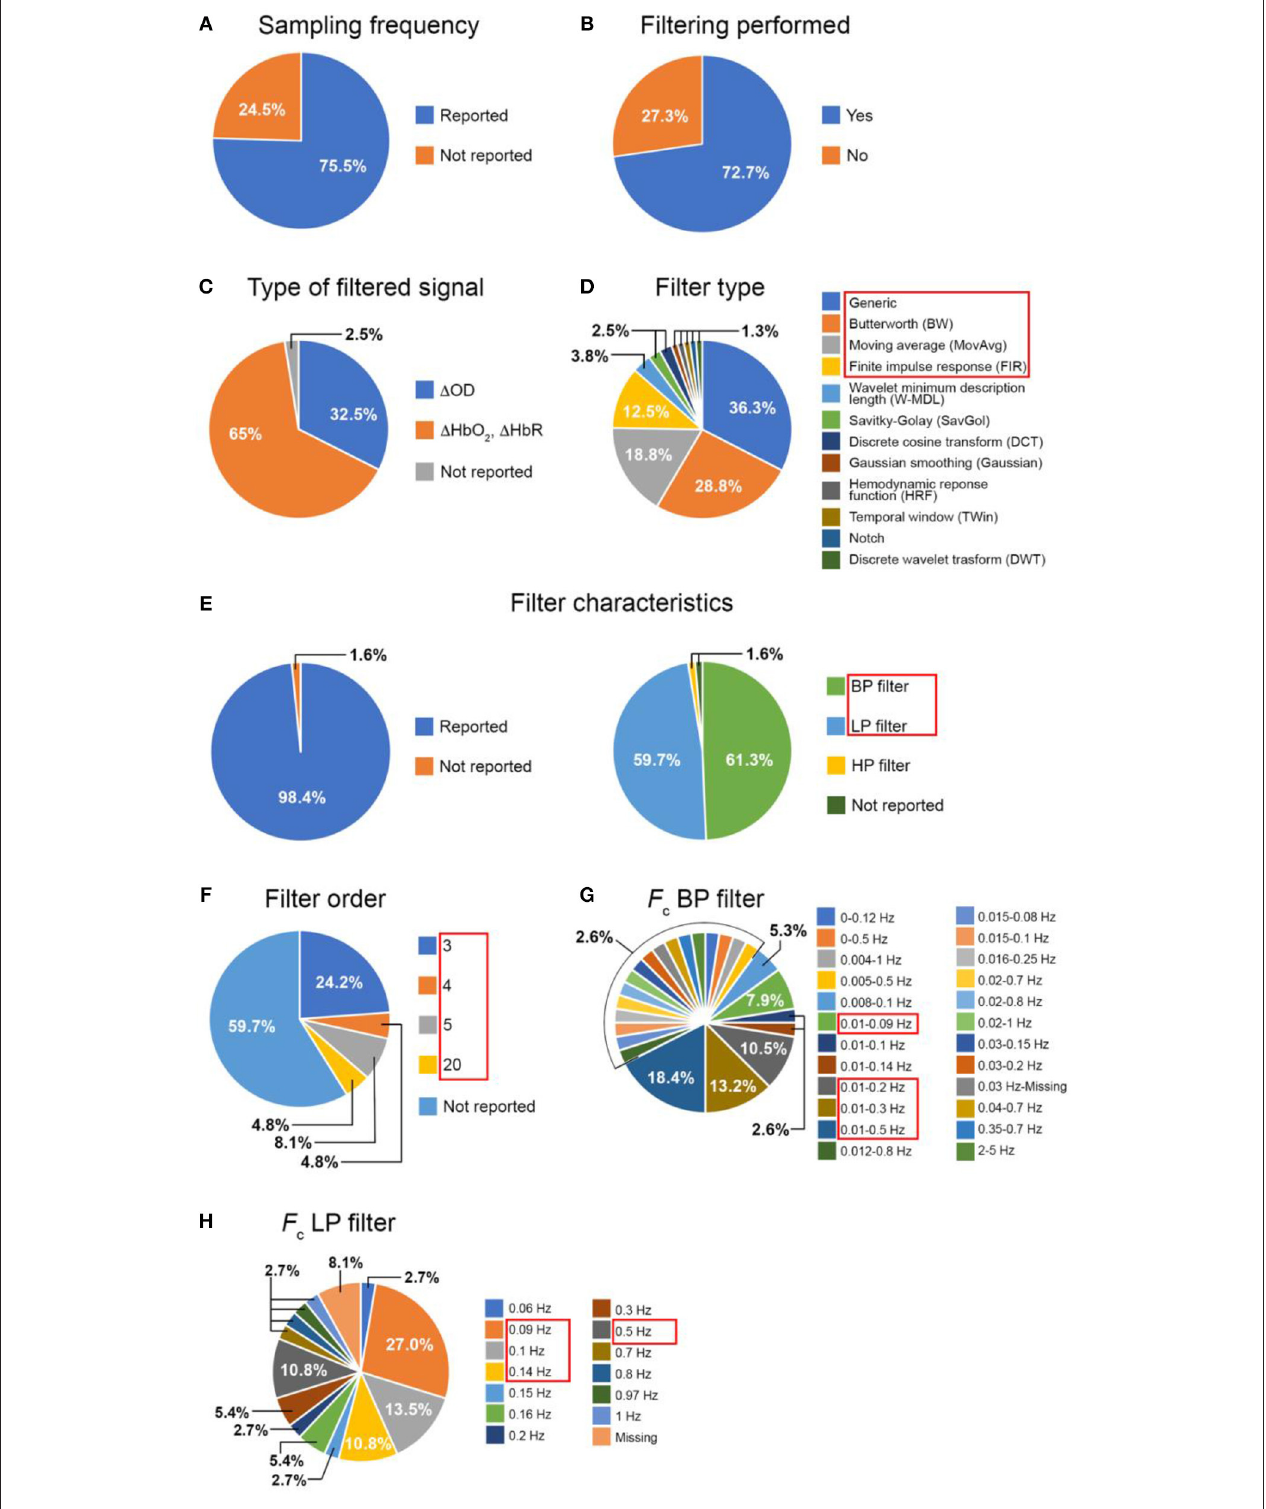
FIGURE 2 | Summary of the literature review results: inclusion of (A) the F s and of (B) a filtering step in the studies; proportion of the filtered signals (C) , filter type (D) , filter characteristics (E) , filter order (F) , F c of band-pass (G) and low-pass (H) filters across the papers that included a filtering step. (BP, band-pass; LP, low-pass).